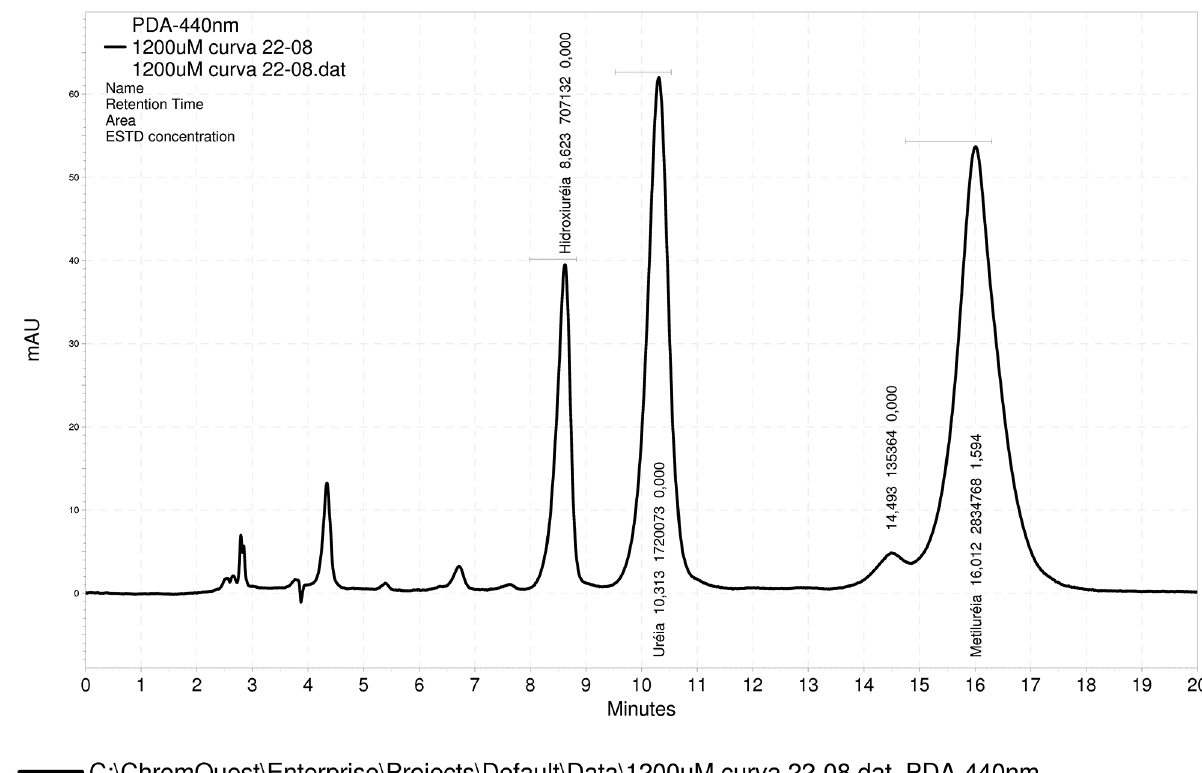
FIGURE 1 - Chromatogram of plasma enriched with 1200 µM hydroxyurea and 15.5 mM methylurea (internal